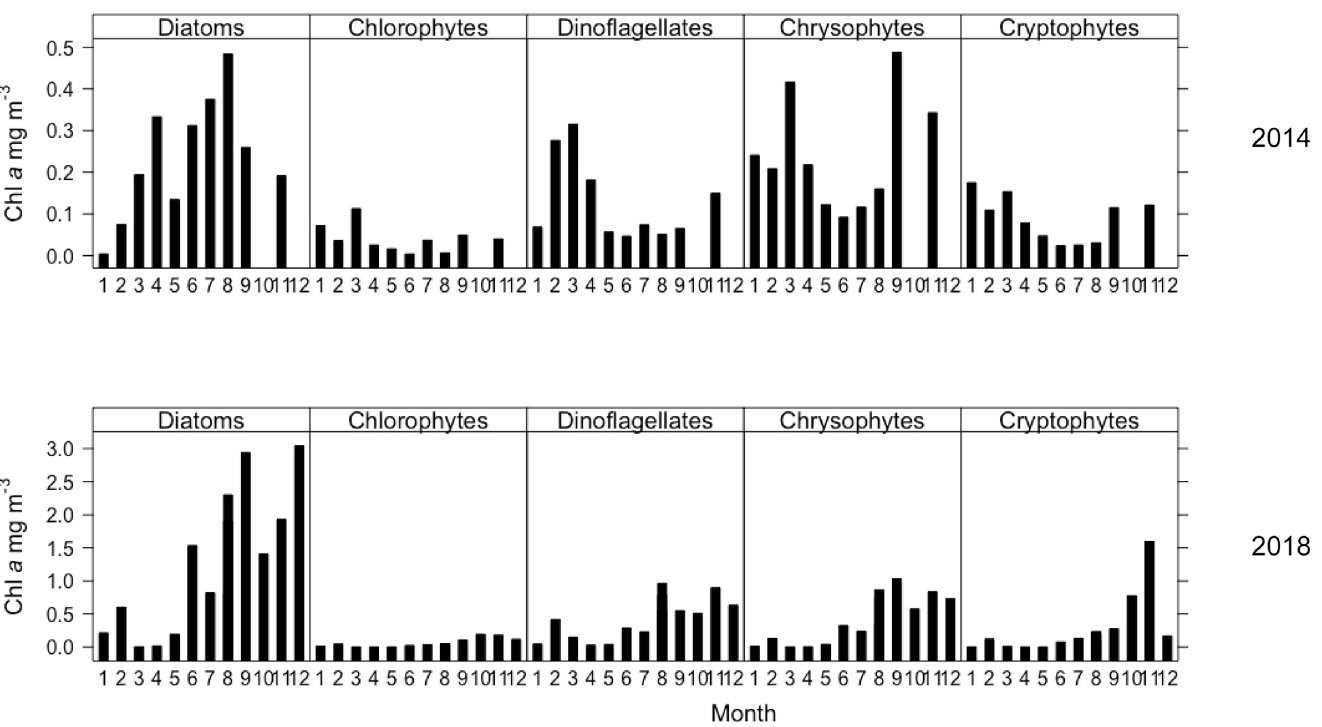
Fig 5. Taxonomic composition of phototrophic picoeukaryotes (0.2–2 μ m) in Lake V õ rtsja¨rv in 2014 (upper) and 2018 (lower). Chl a concentrations for each group are based on pigment analysis, calculated by Chemtax.